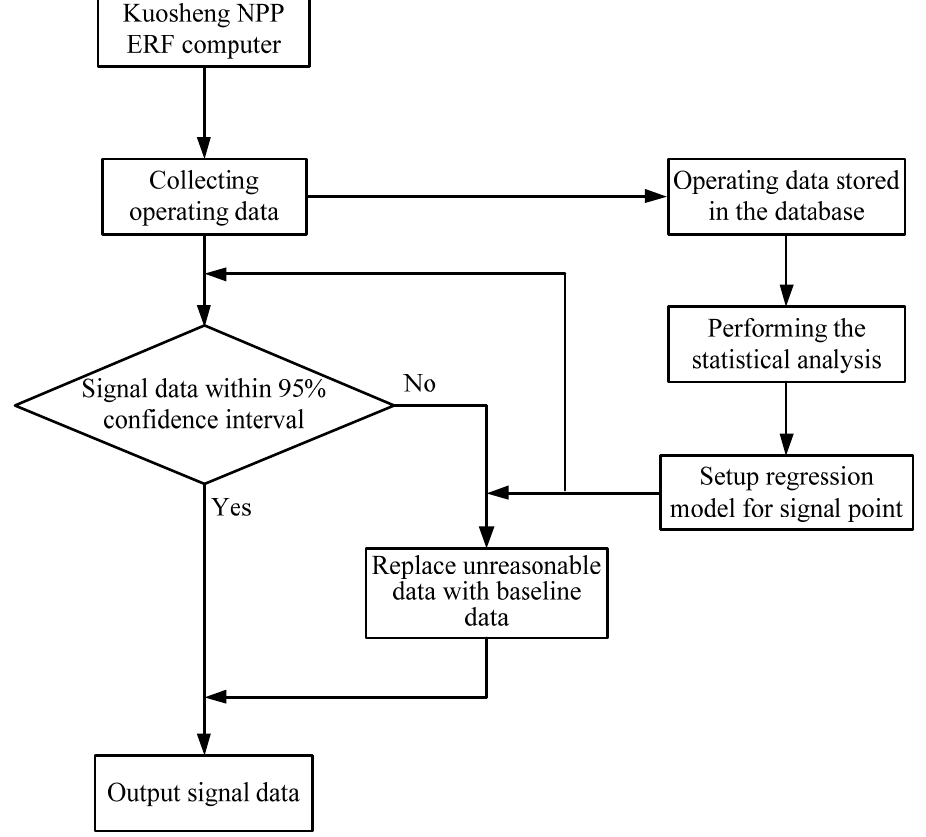
Figure 5. Overall structure for plant operating data acquisition and processing system.